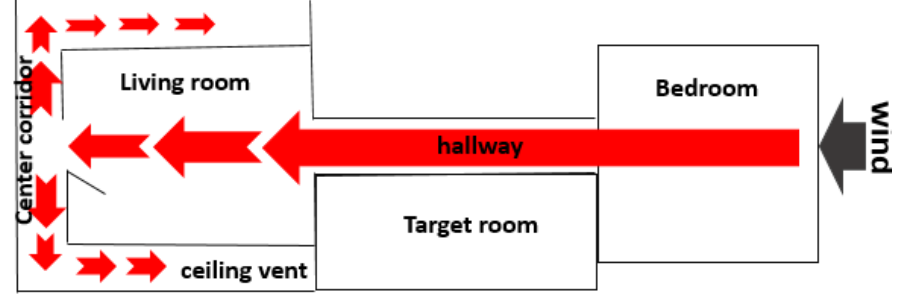
Figure 9. Schematic view of structure in the experimental analysis.